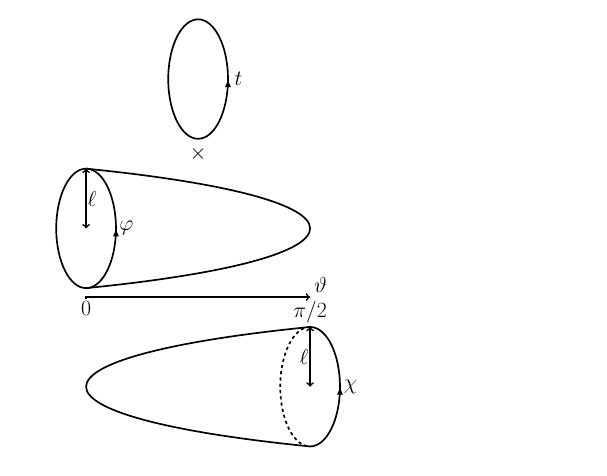
Figure 1 . Depiction of S 3 S 1 and its coordinates. The three-sphere is represented as a torus- (cid:2) (cid:12)bration over an